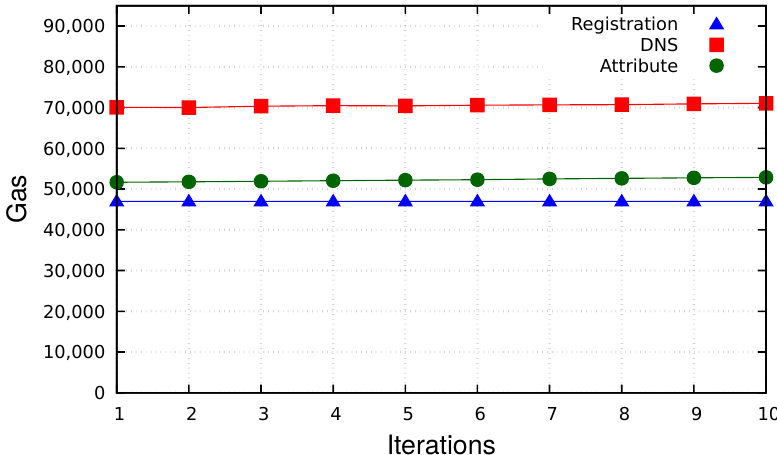
Figure 9. The scalability of the registration, DNS, and attribute functions with the increasing